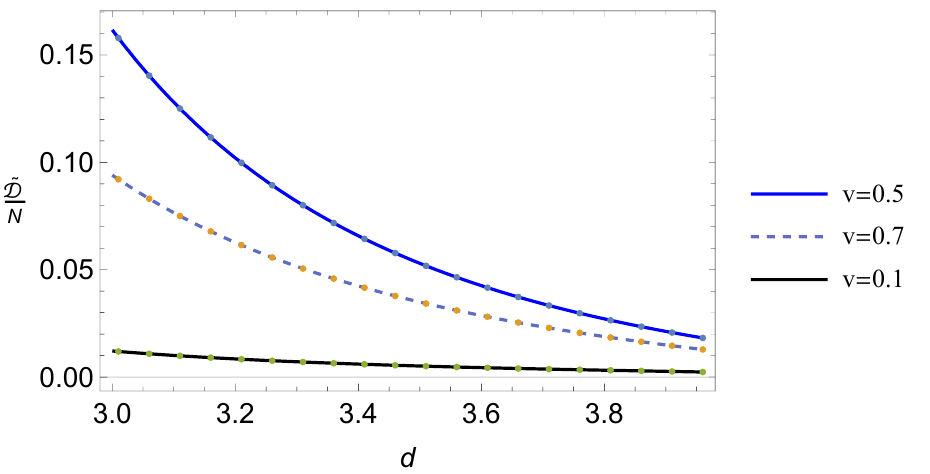
Figure 5. A plot of ˜ D in the large N critical theory between 3 < d < 4 . Solid and dashed lines interpolate numerical